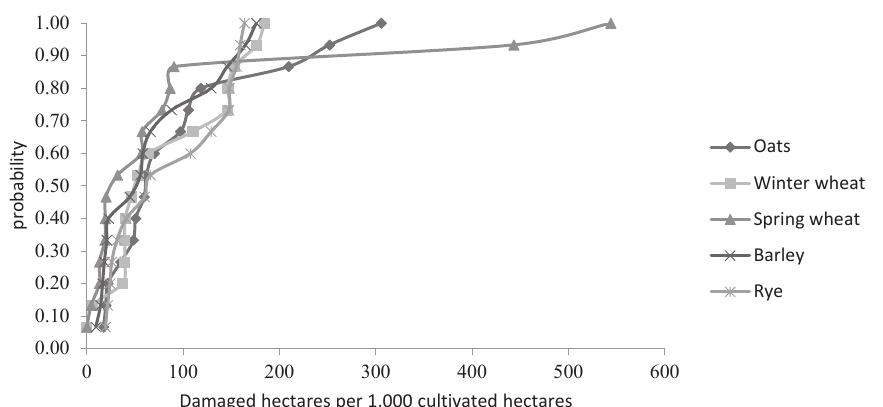
Fig. 1. Cumulative distribution functions of oats, winter wheat, spring wheat, barley and rye in the stochastic simulation model of farm-based insurance